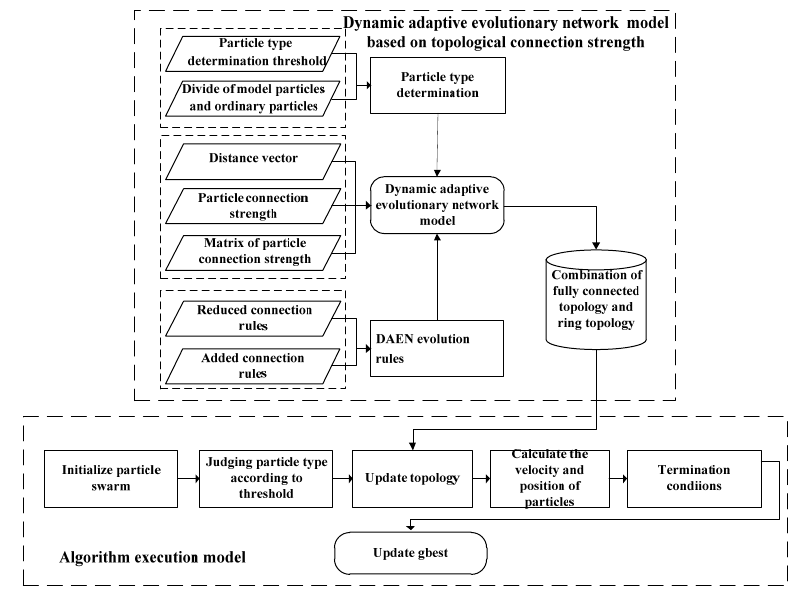
Figure 1. Flowchart of the algorithm.